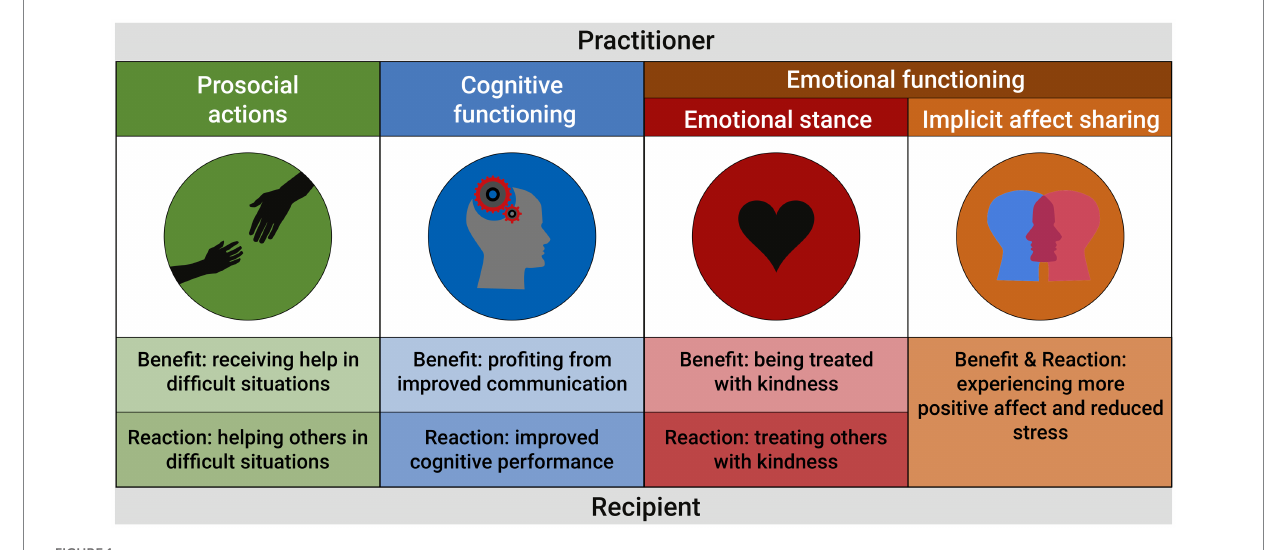
FIGURE 1 Schematic representation of pathways through which meditation effects may spread to others. As a basic mechanism, recipients may simply benefit from meditation-induced effects on the practitioner’s prosocial behavior, cognitive functioning and emotional functioning. They may additionally modify their own subsequent behavior, cognitions or emotions. In the most literal sense of the word spreading, the positive affective states and underlying physiological correlates of a practitioner may also be directly